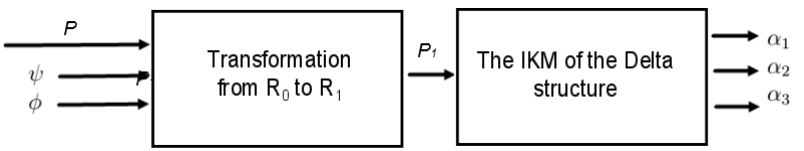
Figure 15. Inverse Kinematics Model of the hybrid